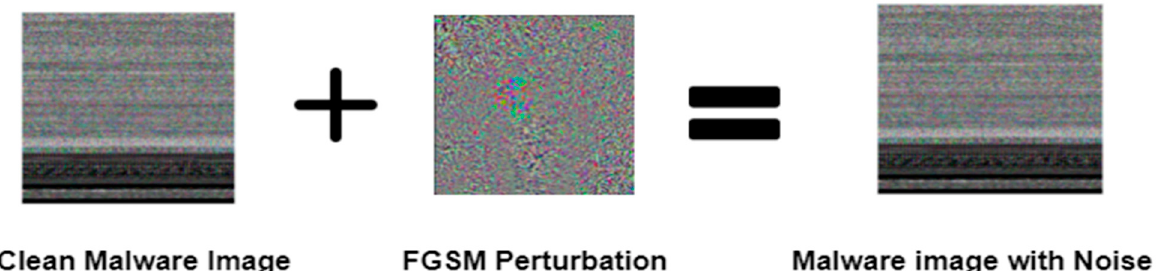
Figure 9. Perturbed image generation in FSGM attack to fool the